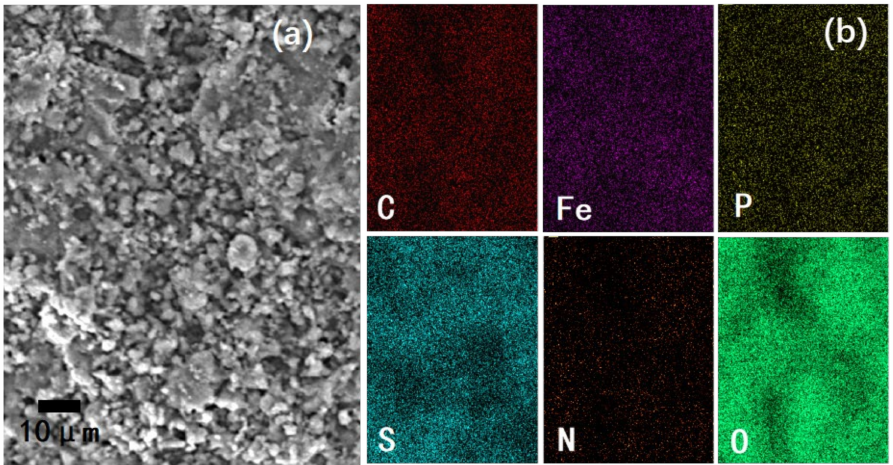
Figure 6. SEM image ( a ) and elemental maps ( b ) of the precipitate after treatment. Conditions: initial pH = 2, applied voltage = 3 V, iron powder = 1.2 g, Na 2 SO 4 concentration = 0.025